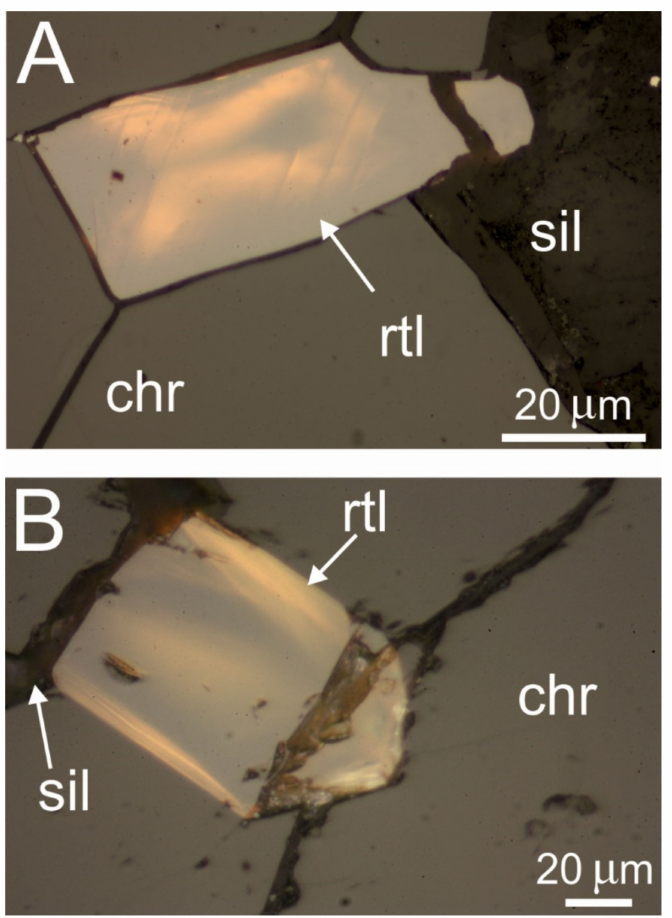
Figure 4. Digital image in reflected plane polarized light showing internal reflection in rutile crystals from the Jacurici ( A ) and UG2 ( B ) chromitite. Abbreviations: rtl, rutile; others as in Figure